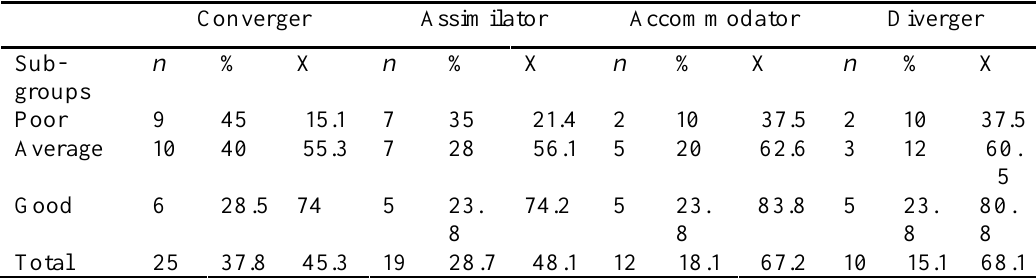
Average Scores of Four Learning Style Groups and their Sub-Groups Converger